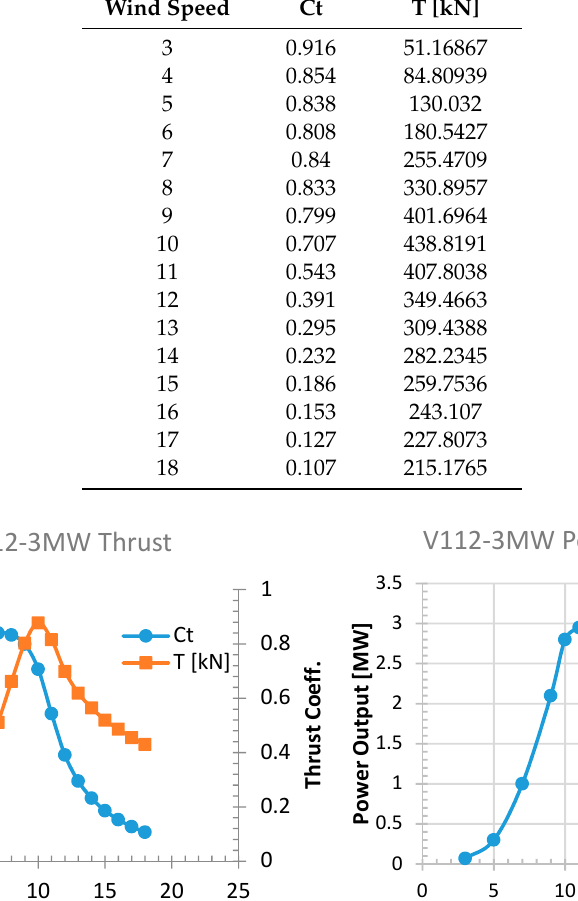
Figure 10. Measured mean monthly wind speeds of Ras Ghareb station at 24.5 and 100 m. Table 5. V112-3MW turbine thrust force and thrust coefficient calculation.